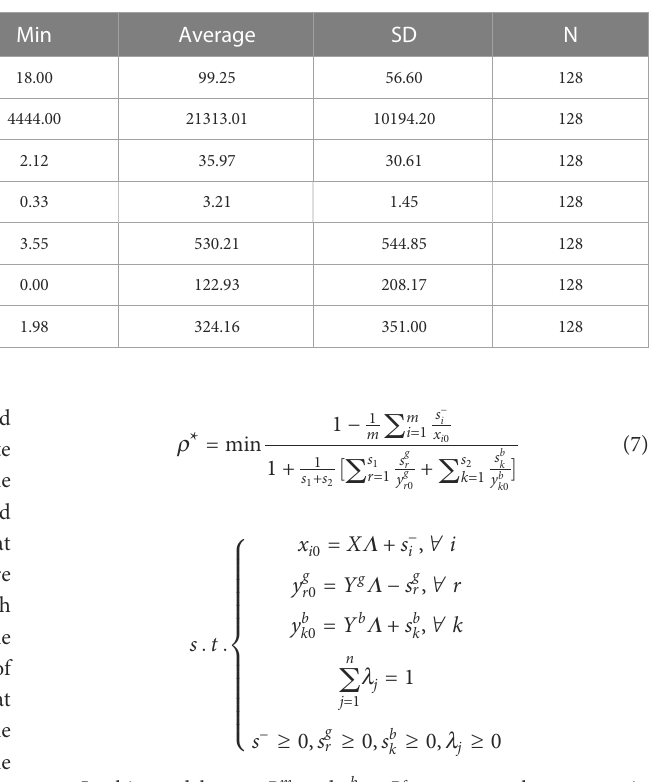
TABLE 3 Summary